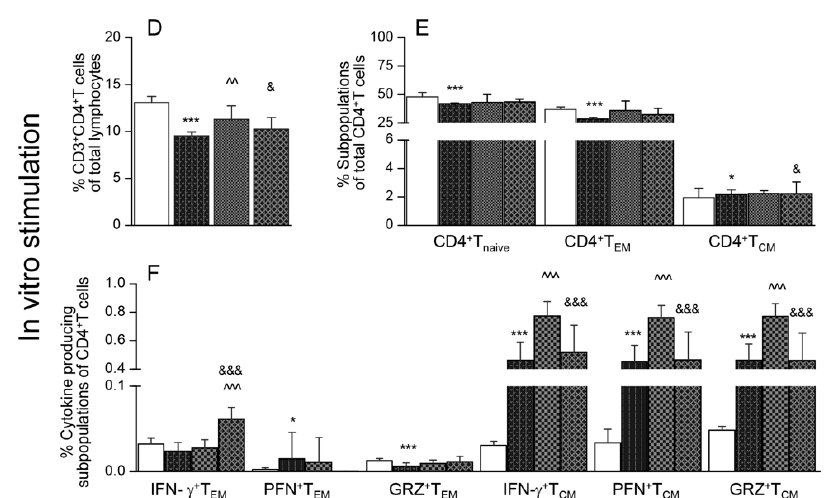
Figure 1. E ff ect of nano-immunotherapy on ex vivo profile and recall response of splenic CD4 + cells in Chagas mice. C57BL / 6 mice (6 weeks old) were challenged with Trypanosoma cruzi (SylvioX10, 10,000 trypomastigotes per mouse) and treated with two doses of TcG2 and TcG4 cloned in